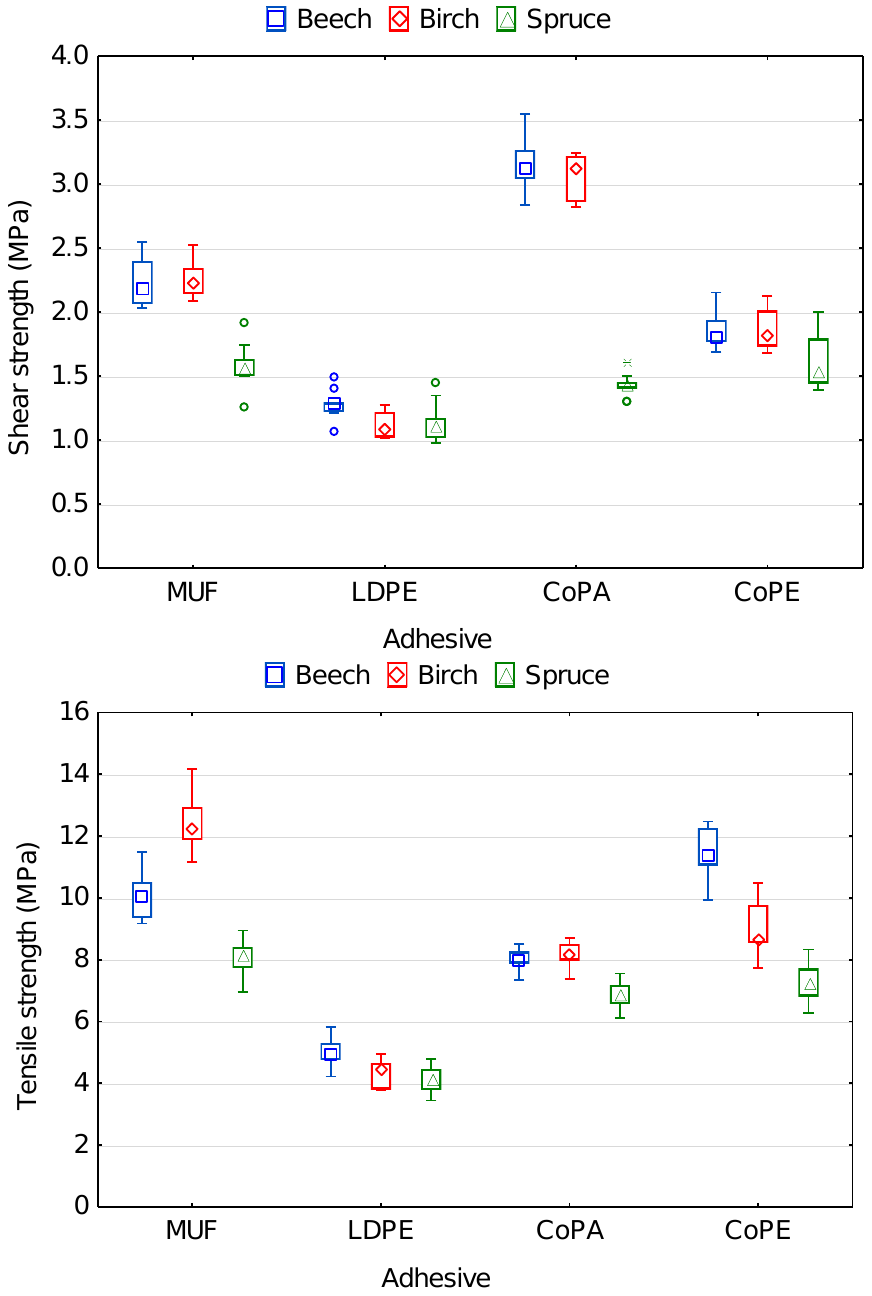
Figure 4. Bonding strength of plywood panels bonded with di ff erent types of adhesive and using various wood species.